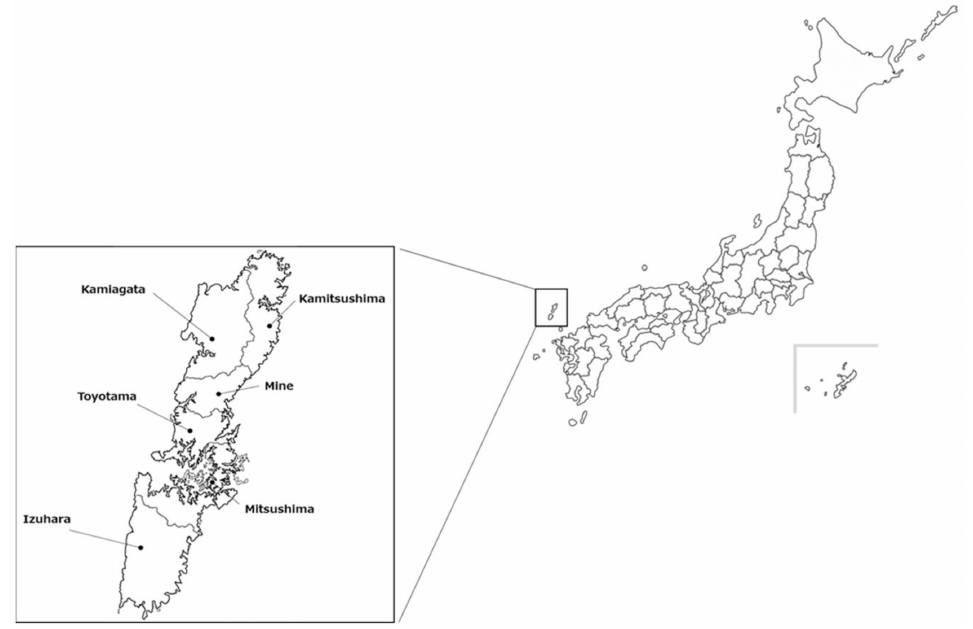
Figure 1. Geographical map of Tsushima Island. Tsushima Island is divided into two main islands: Kamijima to the north and Shimojima to the south. Kamijima is composed of four boroughs (Kamit‑ sushima, Kamiagata, Mine, and Toyotama), and Shimojima has two boroughs (Mitsushima and Izuhara). The Tsushima Leopard Cat Wild Animal Acclimatization Station is located at